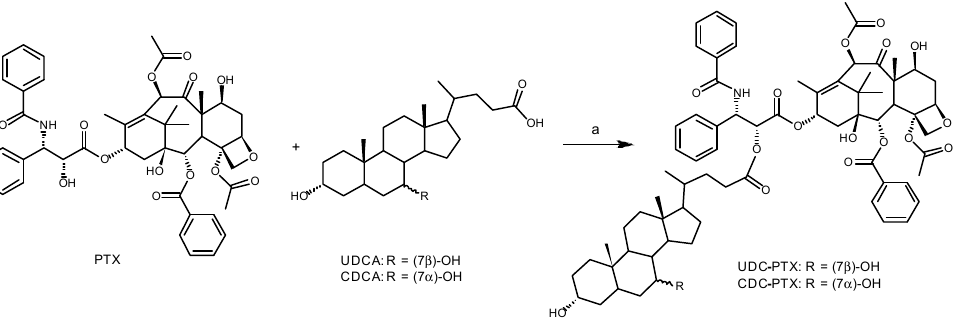
Scheme 1. Synthesis of BA-Paclitaxel hybrids by condensation reaction. (a) EDC hydrochloride, DMAP, DMF, 25 ◦ C, 16 h. UDC-PTX 86% and. CDC-PTX 94%